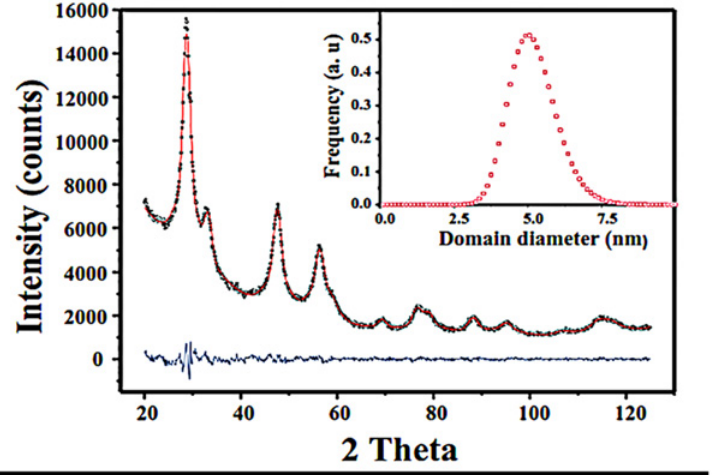
Fig 1. Graphical output of the WPPM modelling of CeO 2 (black open squares are the calculated data, red continuous line the observed data, and the lower blue continuous line is the difference curve between observed and calculated profiles). In the inset is reported ceria crystalline domain size